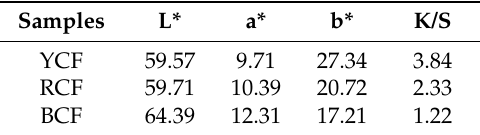
Table 1. Color measurements and K/S values.